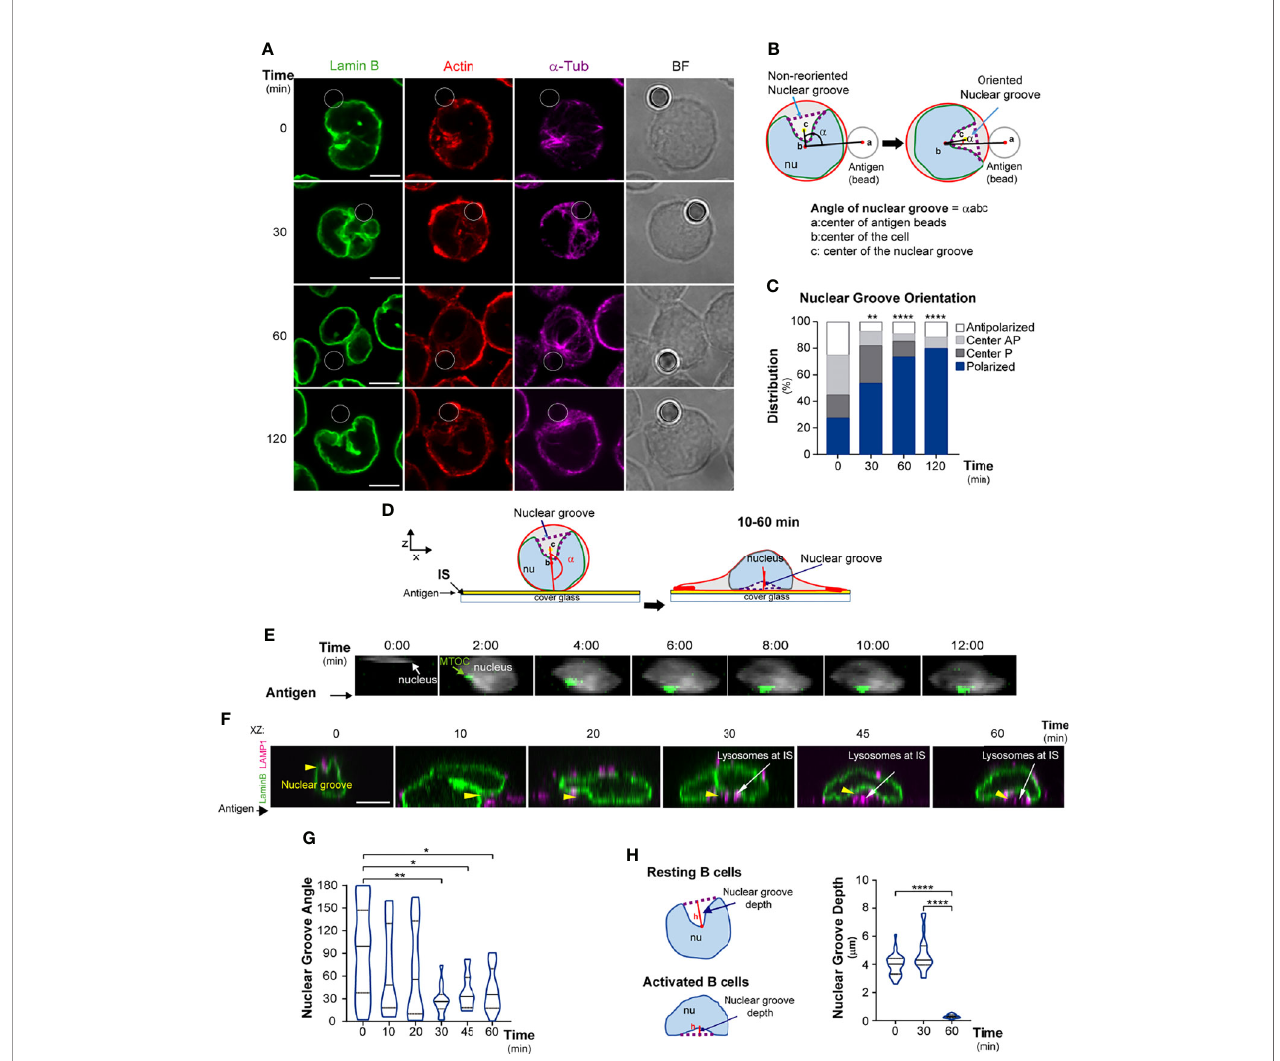
FIGURE 1 | The nucleus reorients towards the B cell immune synapse. (A – D) Representative confocal images of B cells stained for the nucleus (Lamin B, green), actin (phalloidin, red), and microtubules ( a -tubulin, magenta). Cells were incubated with antigen-coated beads (white circles) for 0, 30, 60, and 120 min. (B) Scheme depicting method used to measure the orientation of the principal nuclear groove. (C) Percentage of cells with polarized, central, or non-polarized nuclei with respect to the antigen; n ≥ 90. (D) Scheme of nuclear groove rotation in B cells seeded on antigen-coated dishes. (E) Visualization of nucleus rotation (Hoechst, blue) and MTOC (centrin-GFP) in B cells seeded on antigen-coated dishes ( fi lmed every 2 min). (F, G) Representative confocal images and quanti fi cation of nuclear groove reorientation in B cells seeded on antigen-coated dishes for indicated times, orientation is indicated between 0-180°. Nuclei (Lamin B): green; lysosomes (LAMP1): magenta; yellow arrowheads: nuclear groove; n ≥ 52 cells. (H) Scheme and quanti fi cation of the nuclear groove depth, measuring the height or distance between the point of the nuclear groove farthest from a line traced between the two nuclear lobe apices. All scale bars are 5 µm. Statistical analyses: Kruskal-Wallis with Dunn ’ s multiple comparisons tests (C, H) and unpaired t-tests (G) . *p < 0.05, **p < 0.01, ****p <